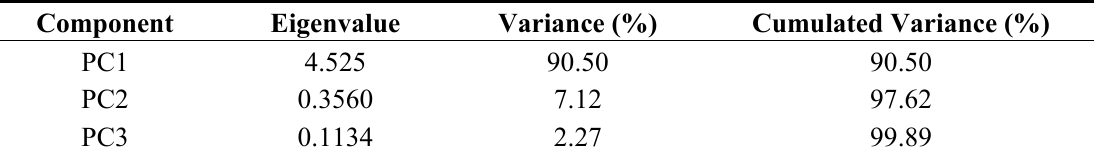
Table 4. Variances (eigenvalues) obtained for the first three principal components.